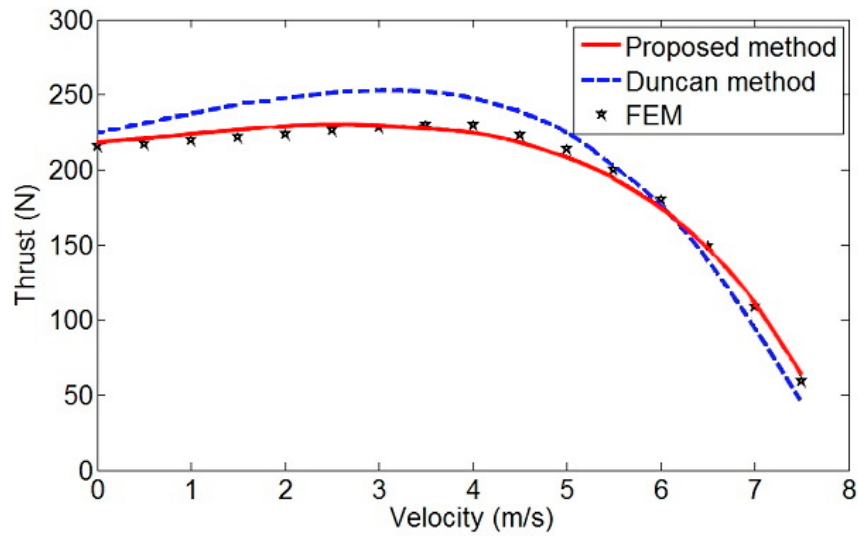
Figure 7. Secondary equivalent resistance variations versus the velocity.